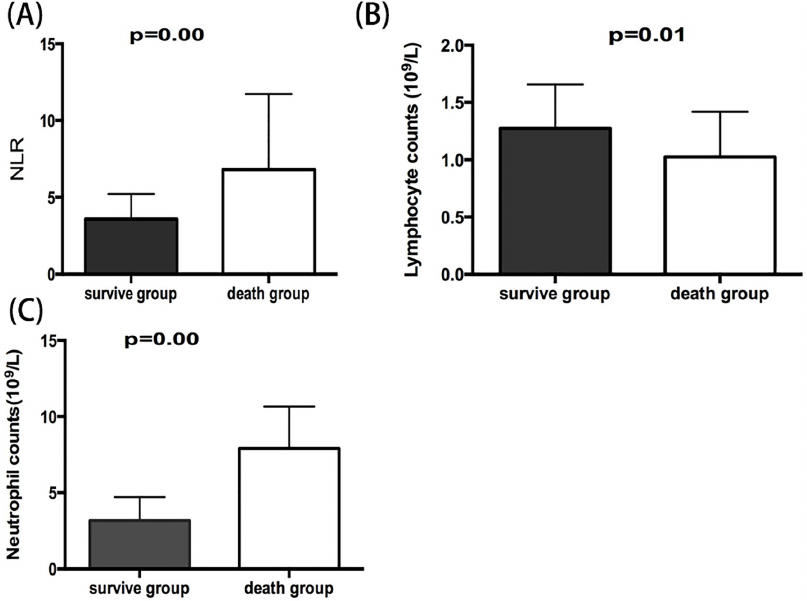
Fig 2. BaselinemedianNLR (A), LC (B), and NC (C) in the ALSS group survivors(solid bars) and in patients who died (open bars). Error bars are